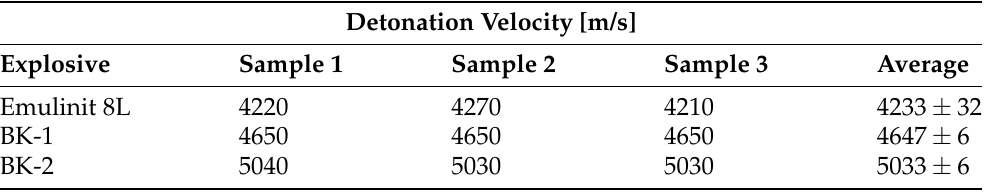
Table 5. Summary of the results of velocity of detonation measurements.